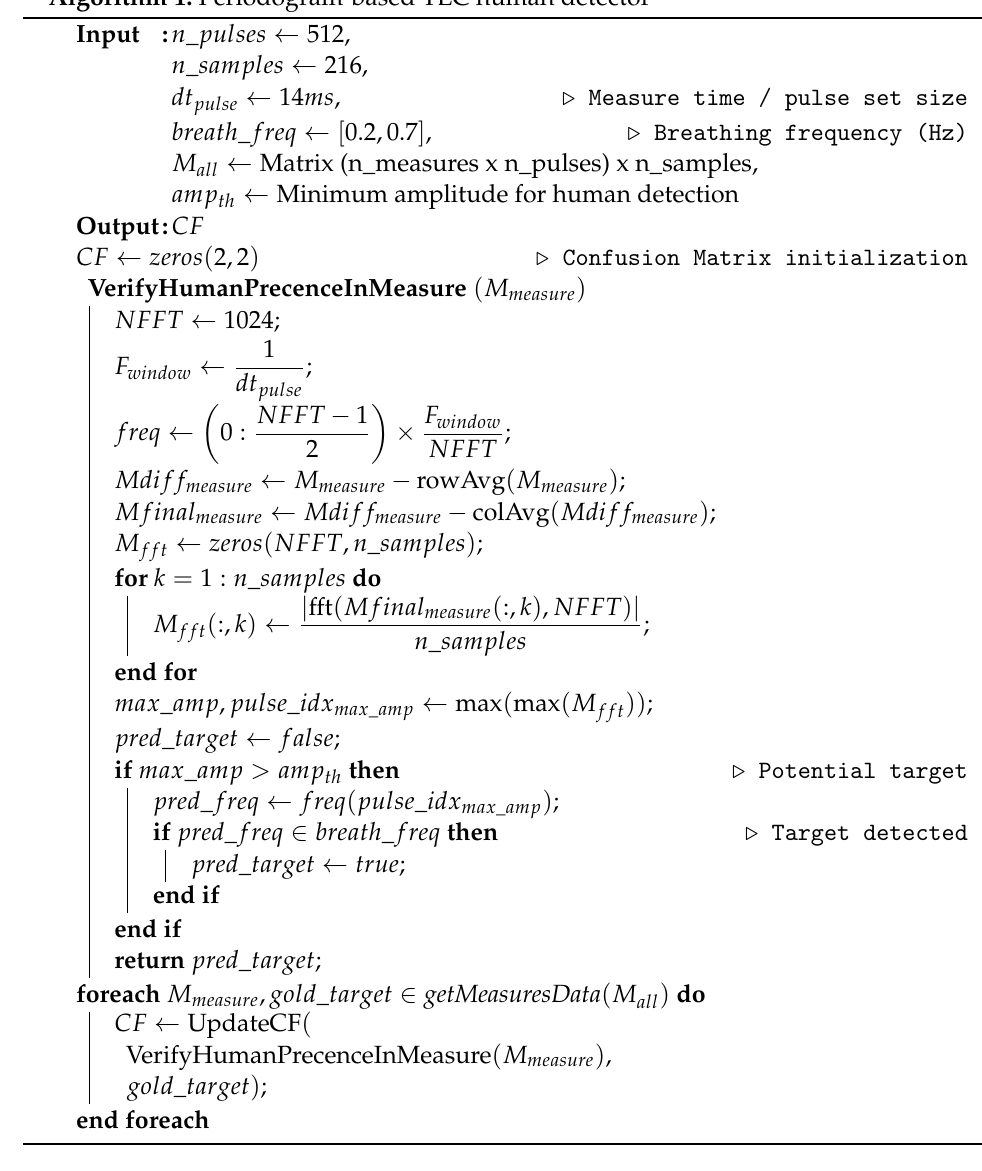
Algorithm 1: Periodogram-based TLC human